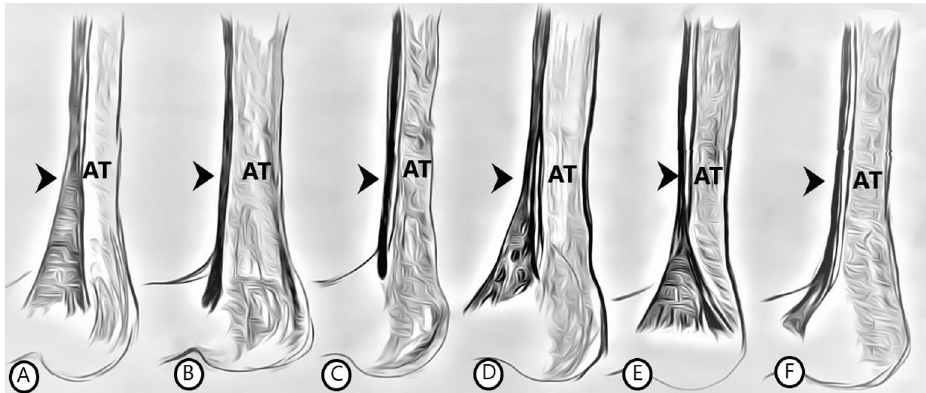
Figure 1. Types of tendon attachments. ( A ) type I, ( B ) type II, ( C ) type III, ( D ) type IV, ( E ) type V, ( F ) type VI. AT Achilles tendon, Arrow plantaris